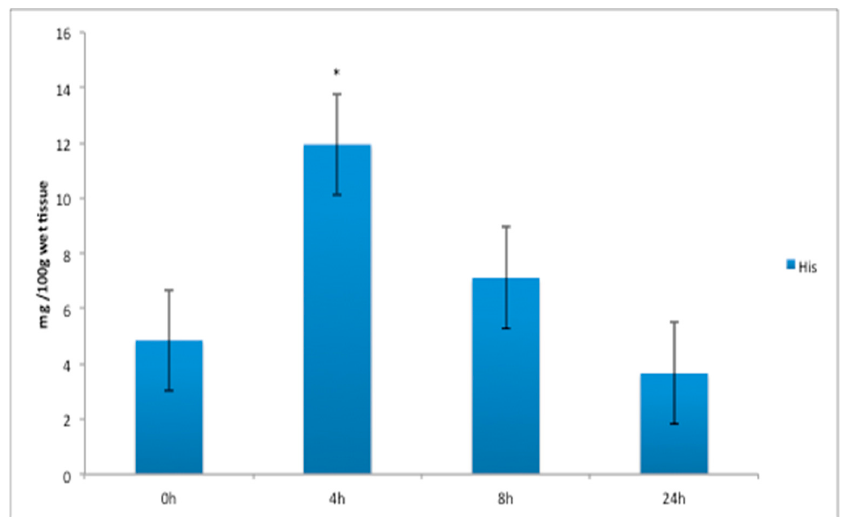
Figure 2. Arginine (Arg) and histidine (His) liver free amino acid (FAA) concentration (mg/100 g wet tissue) before (t = 0 h) and after feeding (4 h, 8 h, 24 h) with the laboratory experimental diet. Data are expressed as mean ± SE, n = 9 fish per time point. The asterisk above bars indicates that there are statistically significant differences among the time after feeding ( p < 0.05).